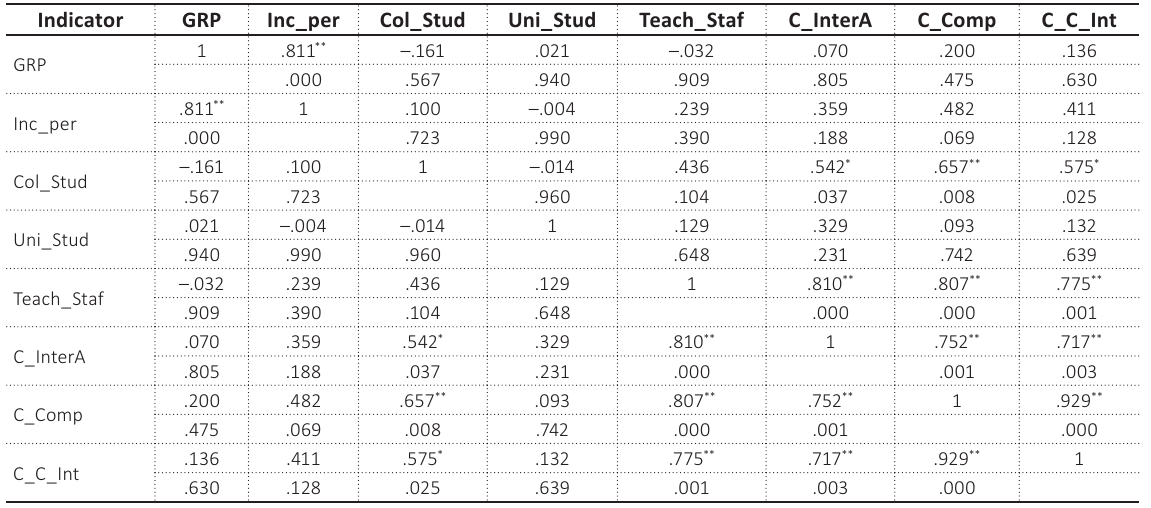
Table 4. Spearman’s rho Correlation matrix – 2010 / Sig.